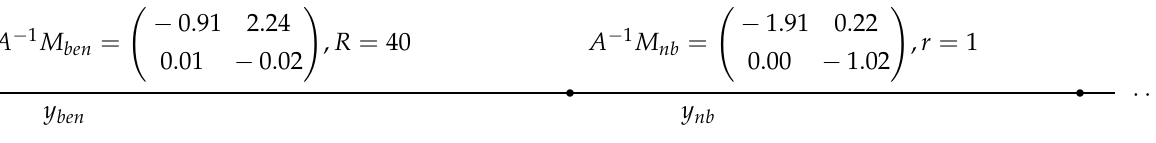
Figure 3. Parameters of control zones for taiga ticks under a two-stage